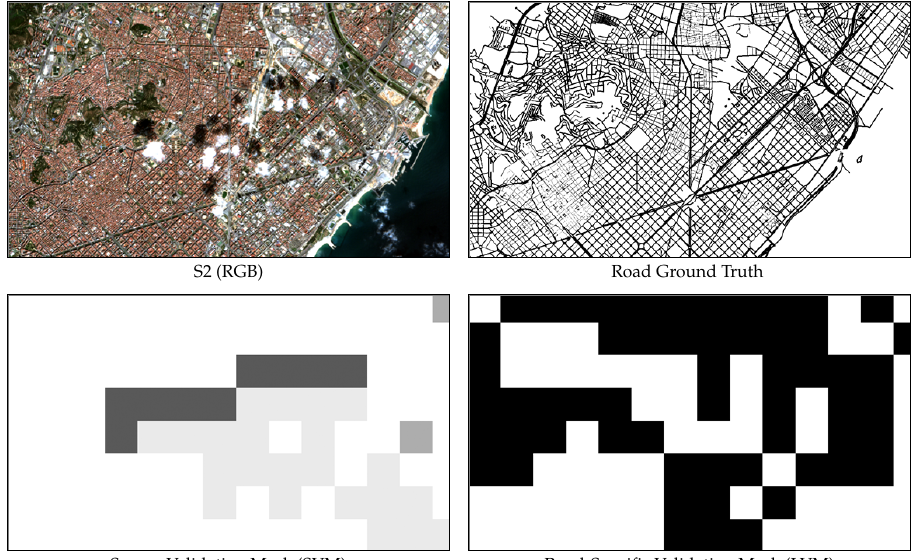
Figure 2. Validation masks generated for Barcelona N.